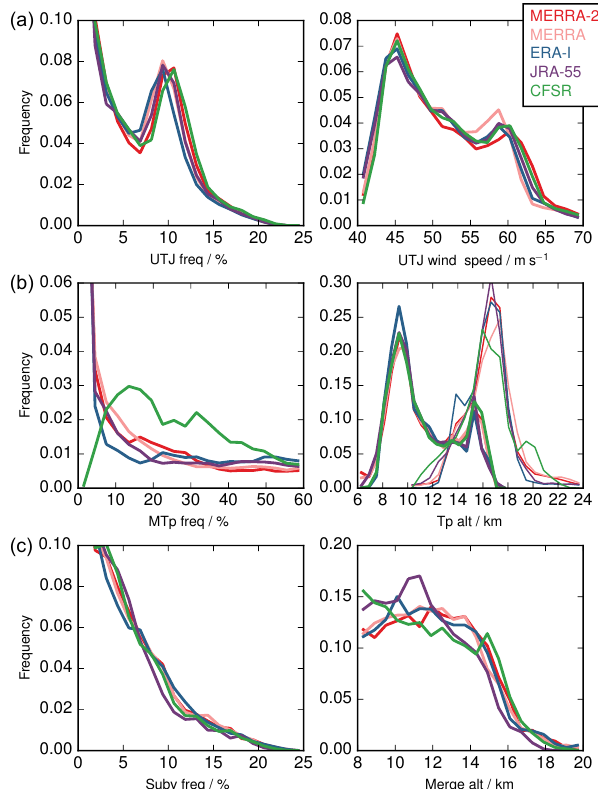
Figure 17. Frequency distributions summarizing the global differ- ences in (a) upper tropospheric jet frequency distributions and wind speeds, (b) multiple tropopause distributions and primary (thick lines) and secondary (thin lines) tropopause altitudes, and (c) sub- vortex jet frequency distribution and merge altitudes for merged subvortex jets. Values summarized are from time series such as those in Figs. 13, 15, and 16. Red, pink, blue, purple, and green lines show MERRA-2, MERRA, ERA-I, JRA-55, and CFSR, re-